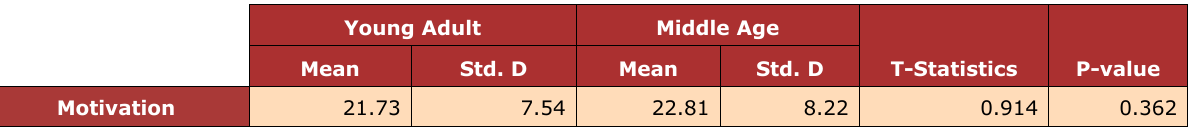
Table 8. Level of motivation of Young Adults and Middle Age (Independent